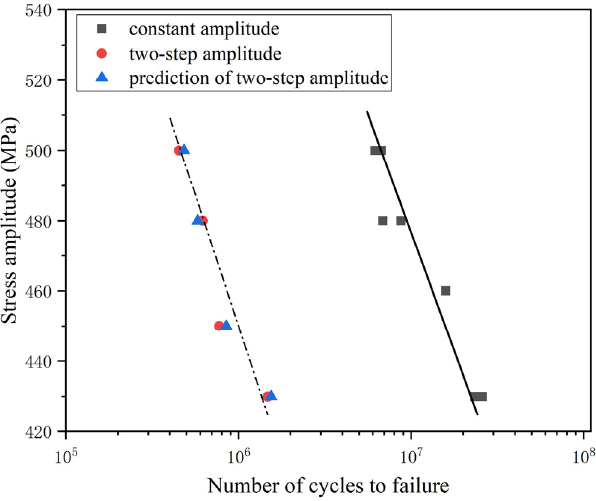
Figure 7. Comparison of the prediction of cumulative life and experimental data for the stress block with the second level of 2 × 10 5 cycles.